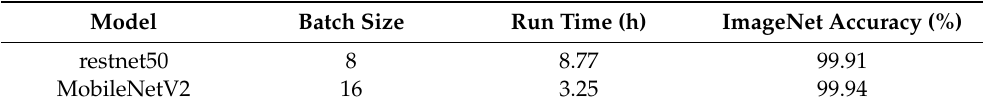
Table 1. MobileNet comparison to popular